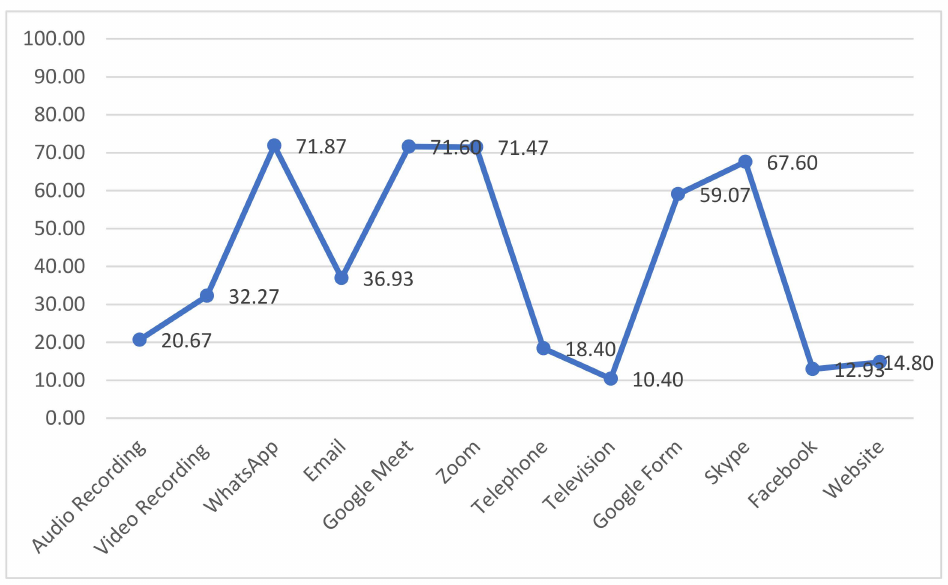
Figure 2. Types of communication techniques applied in instructional supervision